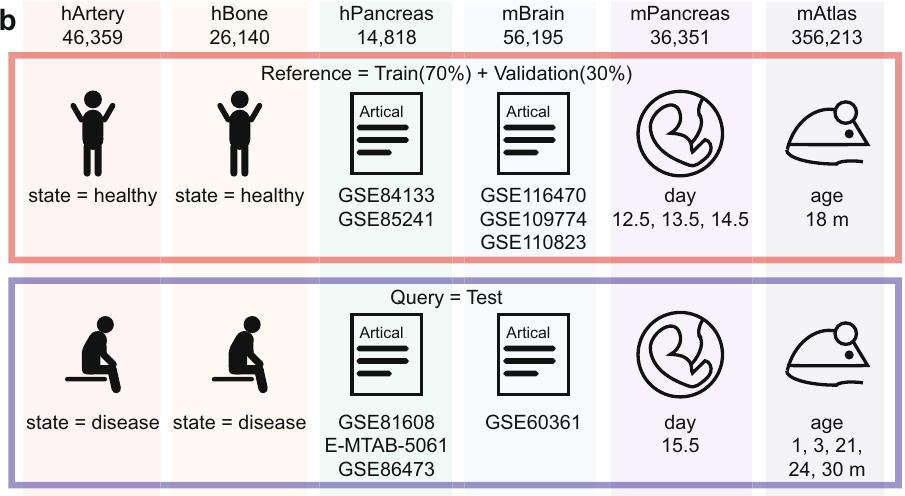
Fig. 1 | Algorithmic framework of TOSICA. a The model is trained on single-cell RNAsequencingdataandcelltypelabelforeachcell.Basedondatabasesorexpert knowledge,masked learnableembeddings are usedto convertthe referenceinput data (n genes) to k input tokens representing each gene set (GS), to which class token (CLS) is added. In the attention function, query (Q), key (K), and value (V) matrix are linearly projected from these GSs and CLS combined tokens and the weights (attention, A) is computed by a compatibility function of the Q with the corresponding K,then assigned to each Vfor computingoutput (O).Ineach Multi-